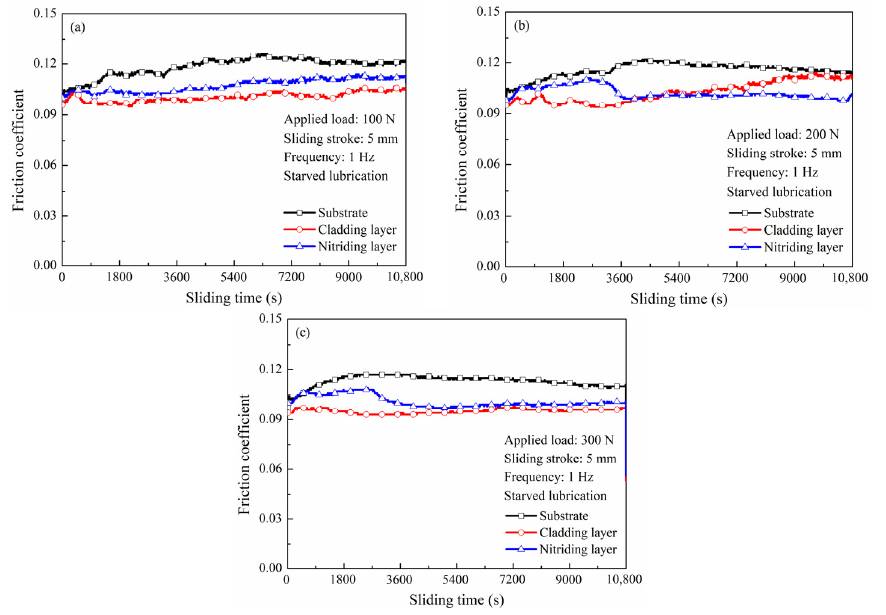
Figure 5. Friction coefficients of three samples at loads of: ( a ) 100 N, ( b ) 200 N, and ( c ) 300 N under starved lubrication conditions.